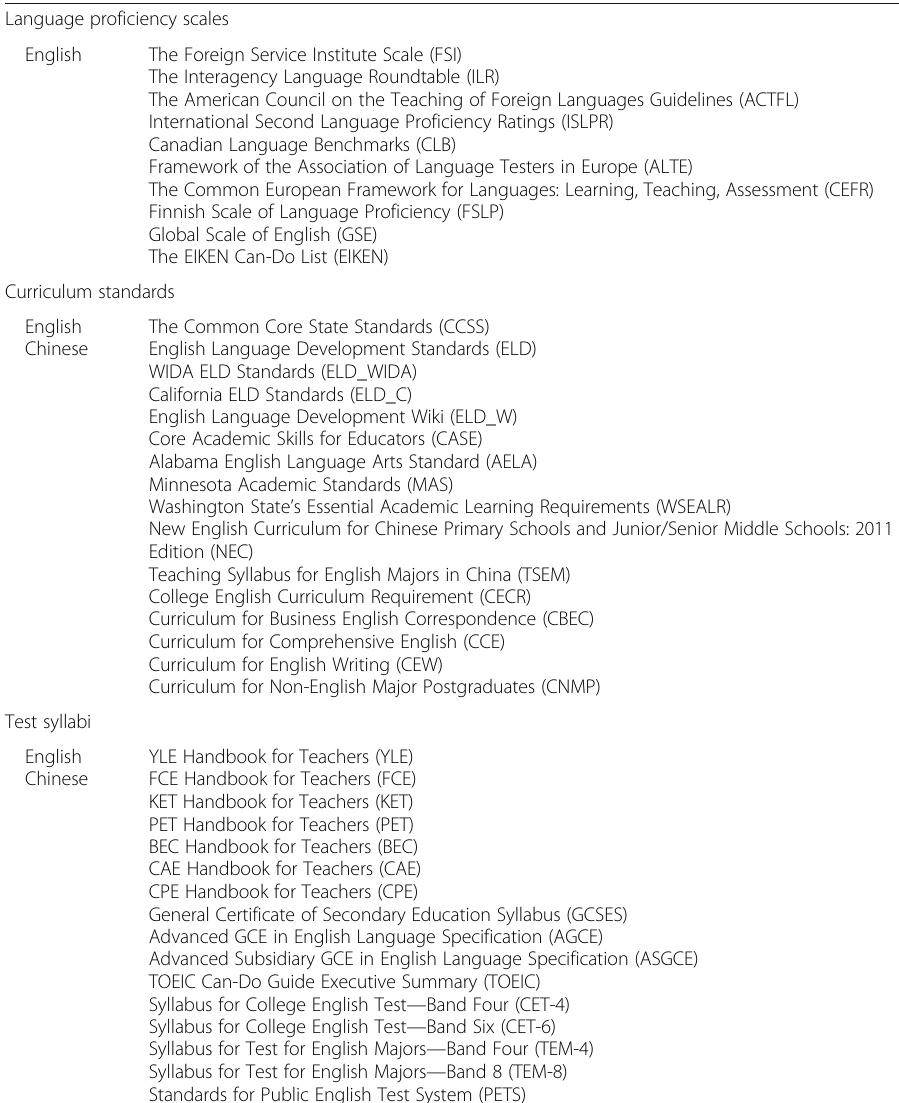
Table 3 An example database for